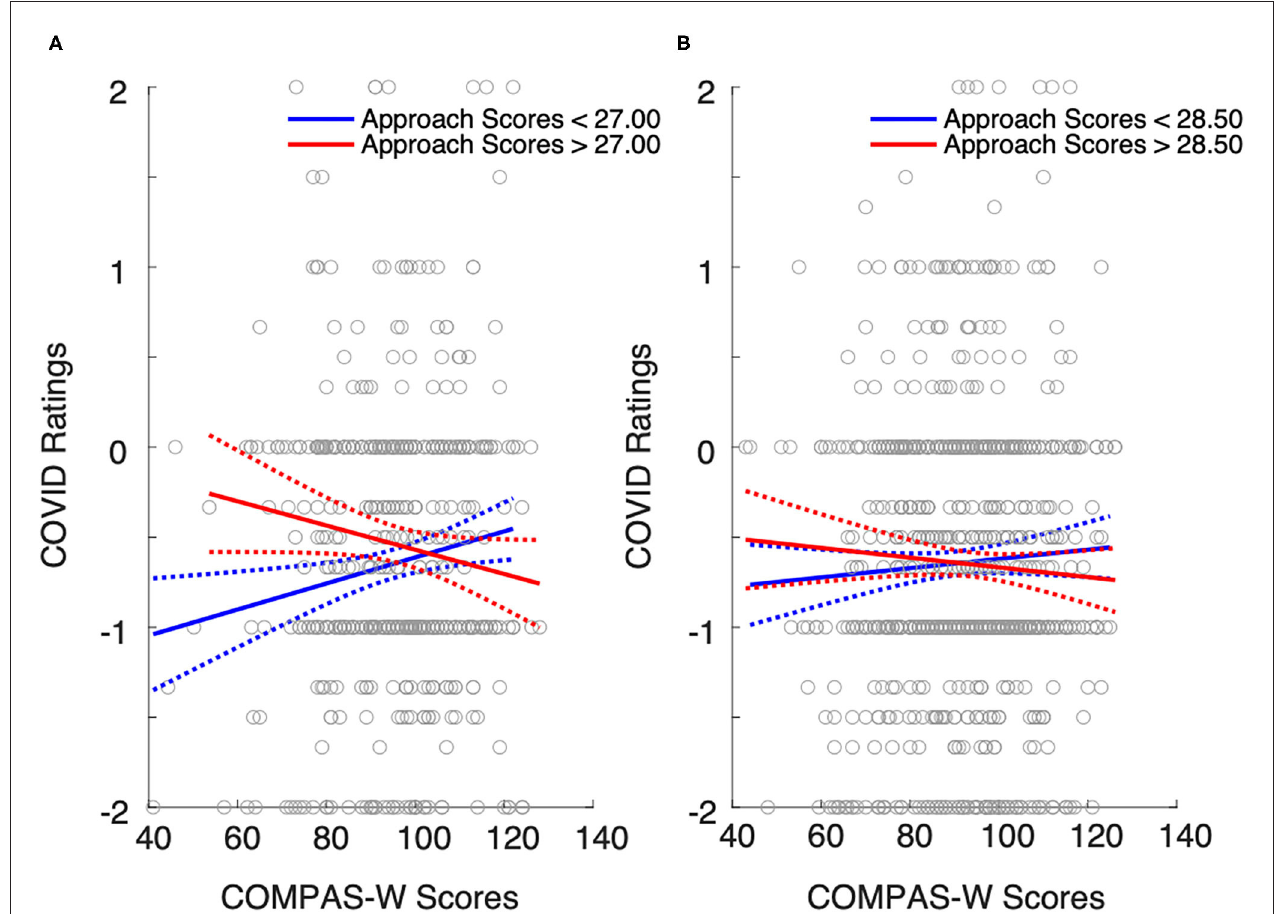
FIGURE 1 | The effect of well-being and Approach coping on the impact of COVID isolation on (A) men and (B) women aged 13–25 years. The blue lines are the least-square regression fits for Approach coping scores below the sample median. The red lines are the least-square regression fits for Approach coping scores above the median. For male participants whose well-being level is low, the employment of Approach coping seems to reduce the negative impact of isolation. This effect does not occur for male participants with high well-being. For female participants, the use of Approach coping does not seem to affect the impact of isolation regardless of their level of well-being. Gray dots represent individual scores for COMPAS-W and COVID ratings. Dotted lines represent 95% confidence intervals.